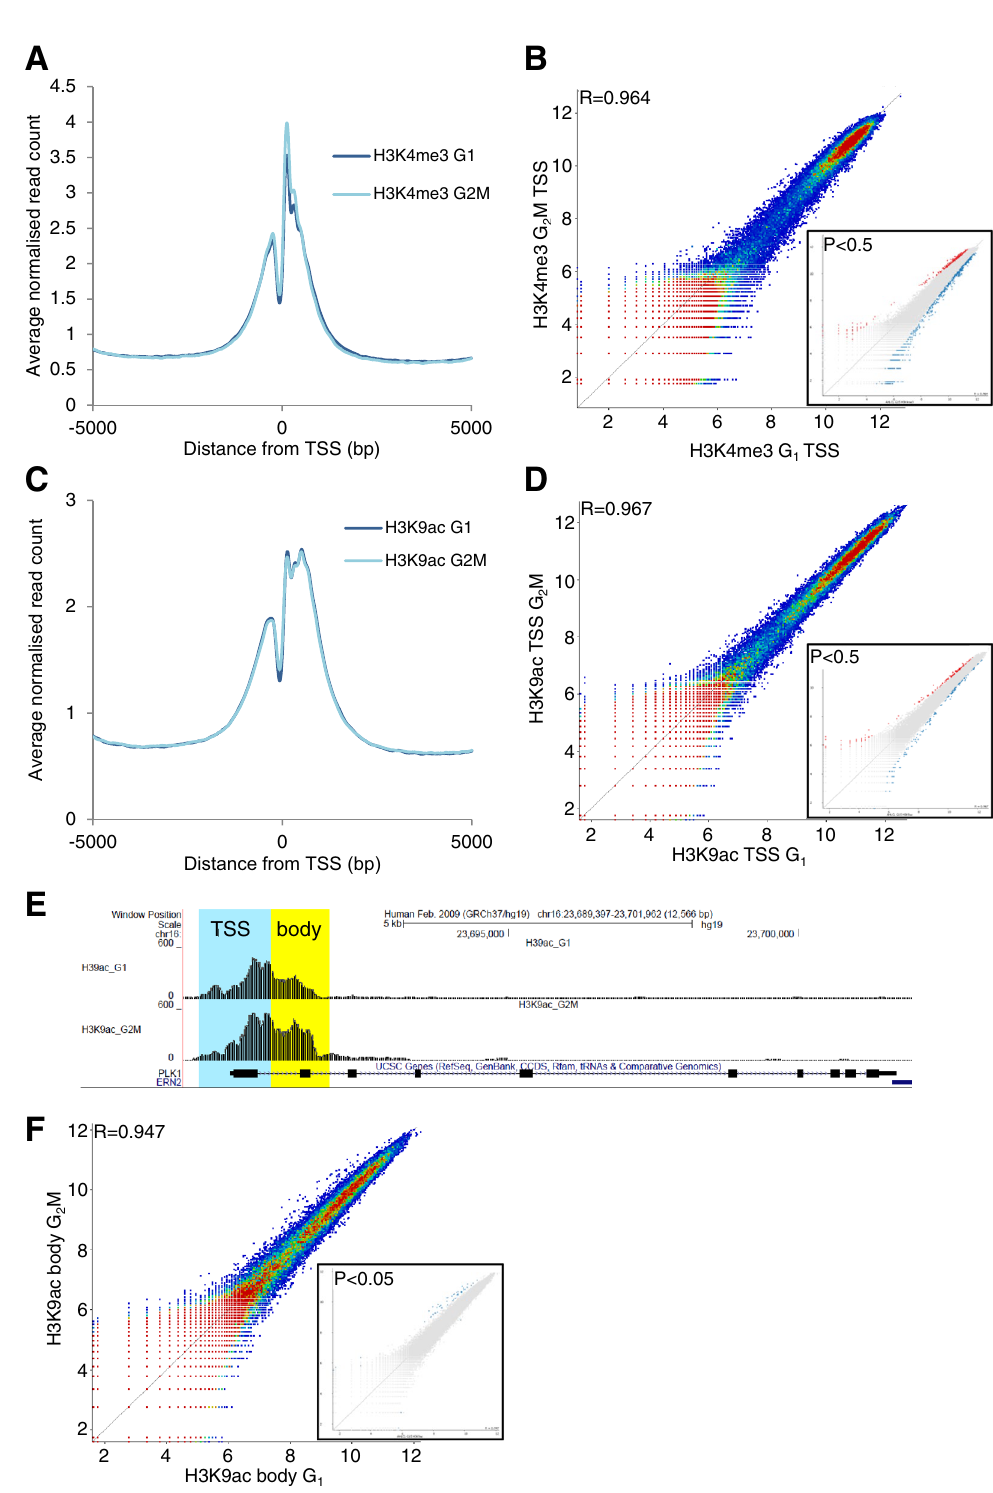
Figure 5. H3K4me3 and H3K9ac enrichment at transcription start sites is conserved in LCL, with outliers representing specific gene function. ( A , C ) Average distribution (average read count normalised to total read count) across a 10 kb window centred on all transcription start sites (TSS) for H3K4me3 ( A ) and H3K9ac ( C ) in G 1 and G 2 M in LCL. ( B , D ) Modification levels at the proximal TSS (− 500 to + 750 bp) are compared by dotplot for H3K4me3 ( B ) and H3K9ac ( D ). Outliers were selected by intensity difference (P < 0.5, insets) for ontology analysis. ( E ) Extension of the H3K9ac signal further into the gene body (+ 750 to + 1750 bp) was observed for a few genes with function in mitosis, e.g. PLK1. ( F ) Comparison of H3K9ac enrichment in this region is shown and outliers highlighted (P < 0.05,